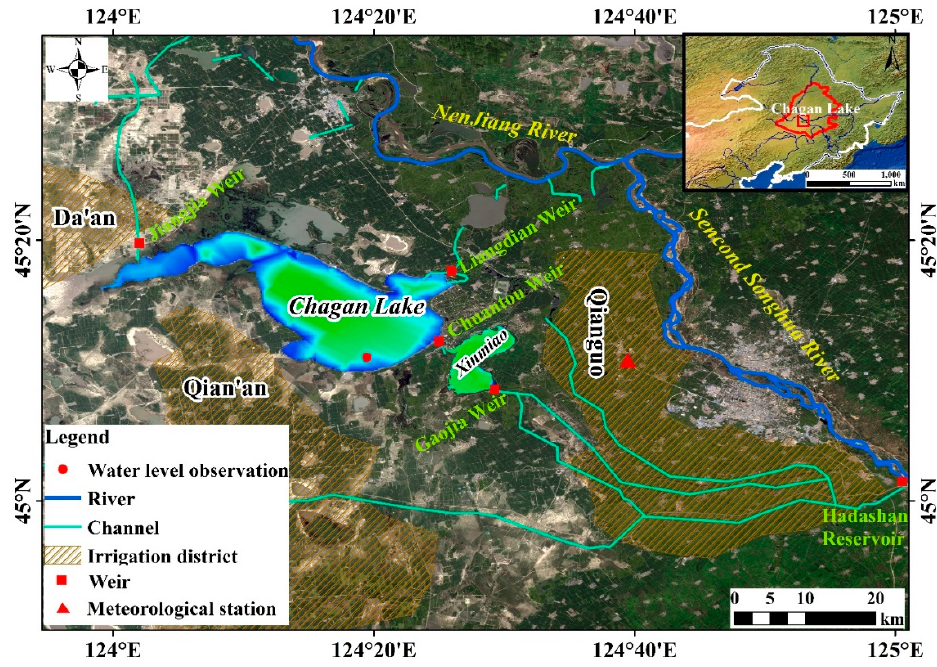
Figure 1. Location of the study area.